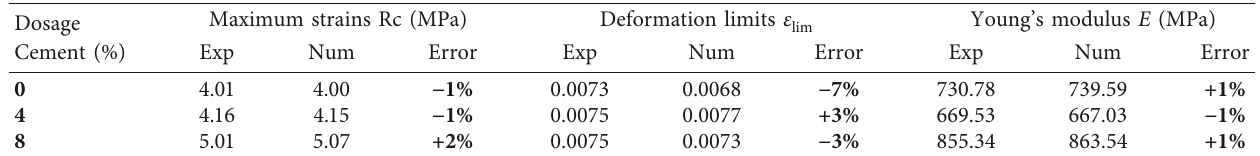
Table 4: Mechanical characteristics of GAD’s CEBs and